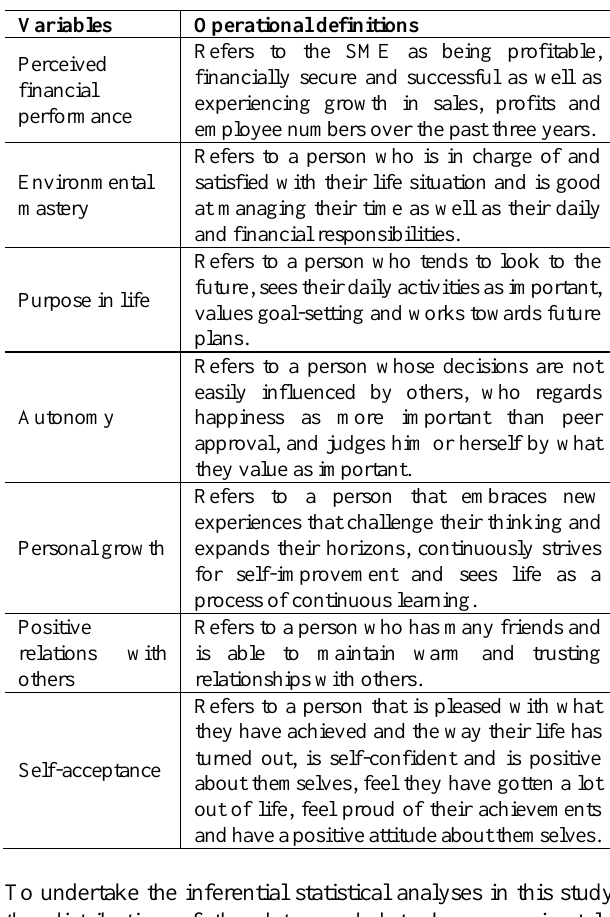
Table 3: Operational